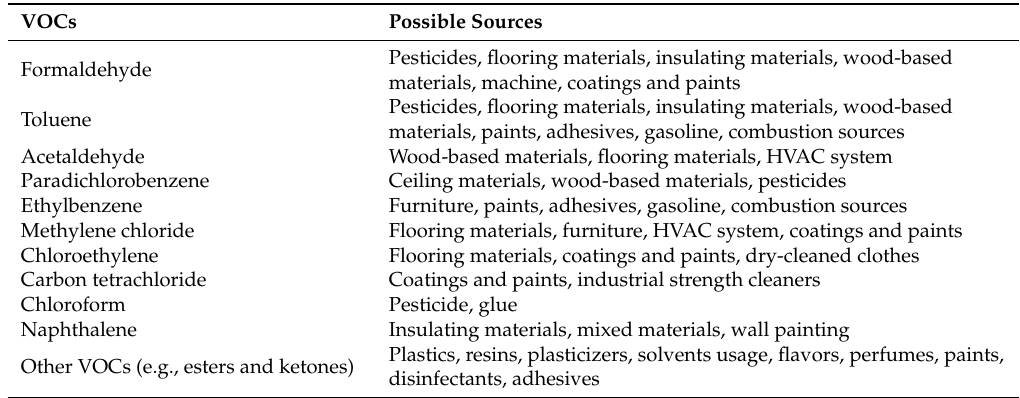
Table 1. Potential sources of indoor